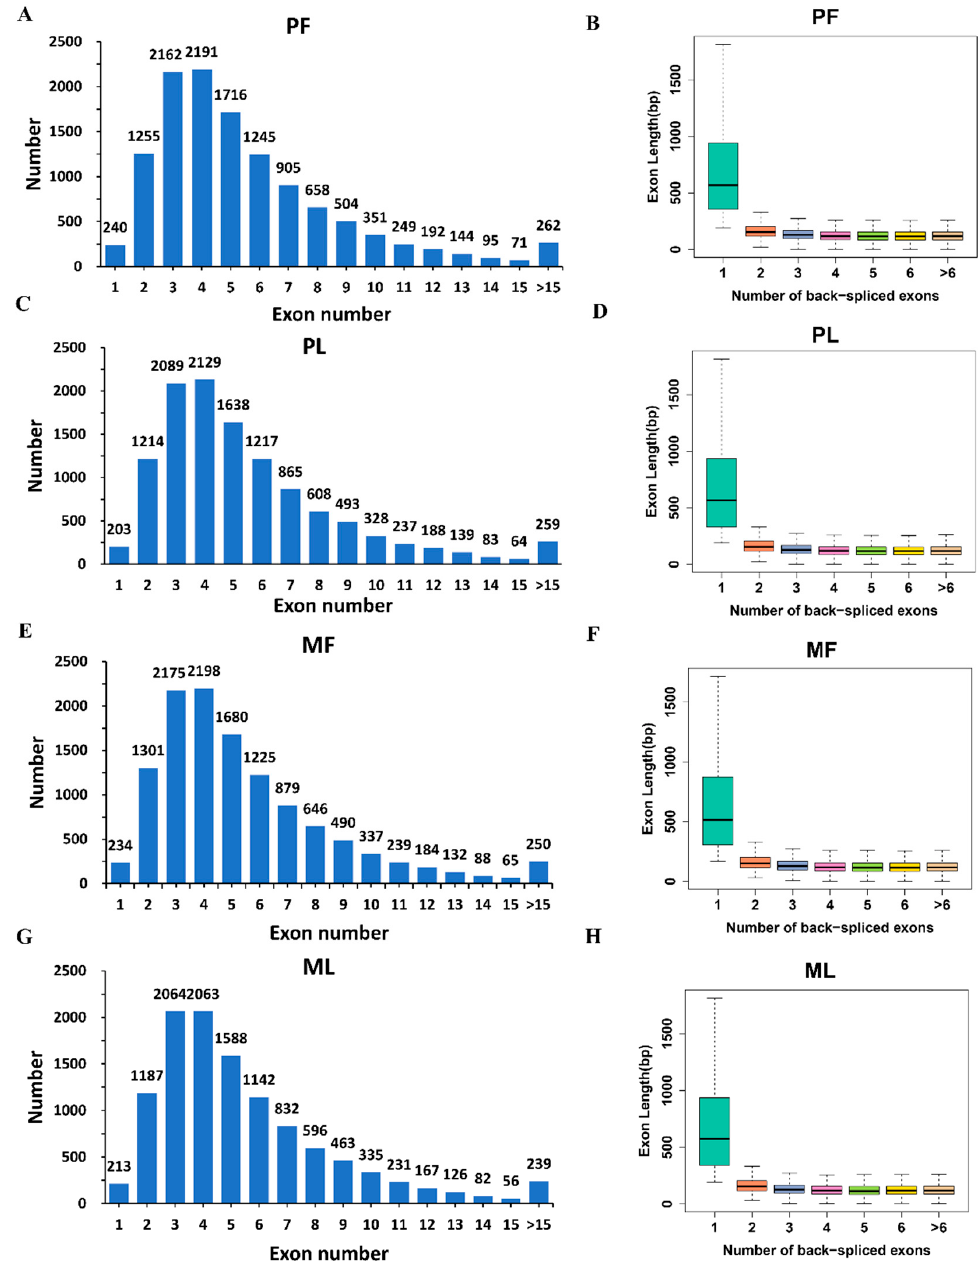
Figure 3. An overview of the exon number and length of identified circular RNAs (circRNAs). The exon number ( A ) and length ( B ) distributions of circRNAs in polytocous sheep in the follicular phase (PF). The exon number ( C ) and length ( D ) distributions of circRNAs in polytocous sheep in the luteal phase (PL). The exon number ( E ) and length ( F ) distributions of circRNAs in monotocous sheep in the follicular phase (MF). The exon number ( G ) and length ( H ) distributions of circRNAs in monotocous sheep in the luteal phase (ML).